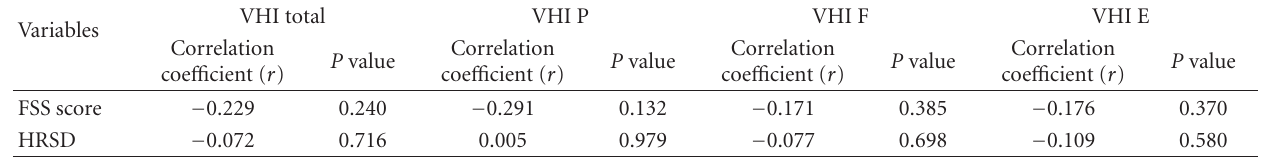
Table 4: Association of VHI scores with selected variables among